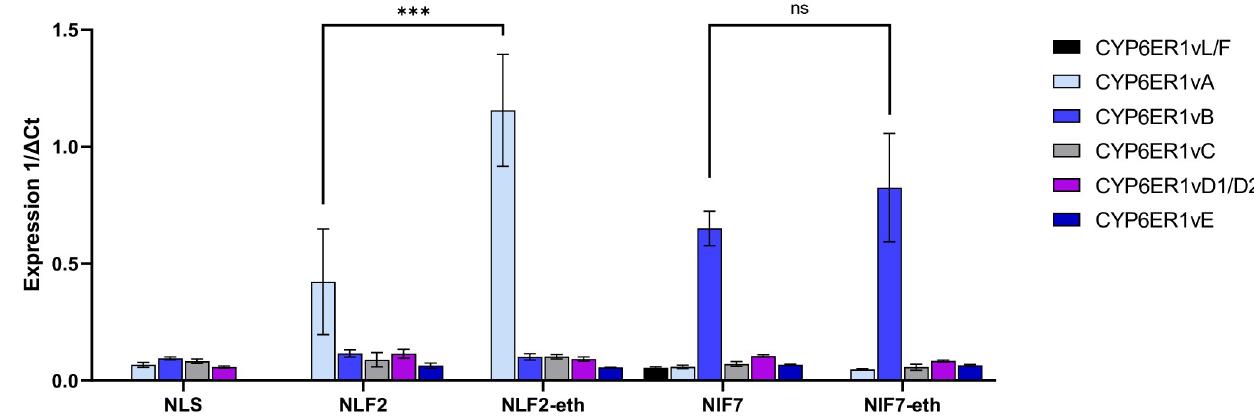
Fig 1. Relative expression of CYP6ER1 variants in ethiprole selected (NLF2-eth and NLF7-eth) and unselected N . lugens field strains (NLF2 and NLF7) and a reference susceptible strain (NLS), as determined by variant-specific quantitative PCR. Error bars indicate 95% confidence intervals (n = 4). Lines above bars are used to denote significant (n.s., non significant at p = < 0.05, ��� , significant at p = < 0.001) differences in variant expression between selected and unselected strains as assessed by one-way ANOVA with post-hoc Tukey HSD.